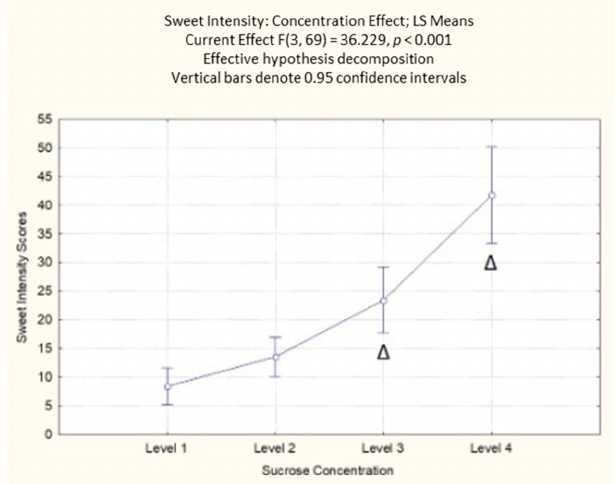
Figure 3. Concentration effect on perceived sweetness responses with different sucrose concentration levels. The order of the levels corresponds with the different sucrose amounts (38; 83; 119; 233 g/kg). ∆ indicates a significant difference from all other sucrose levels < 0.001.